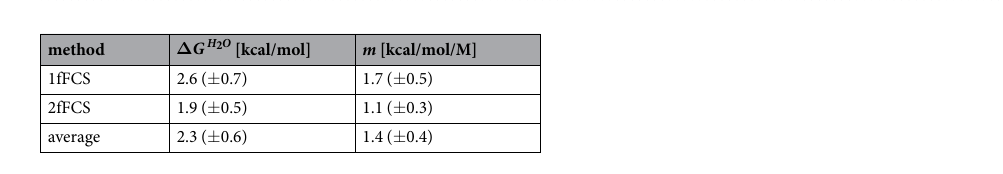
Table 2. Fit parameter from fitting the unfolding curves (Fig. 3A and B) to the two-state unfolding model (equation